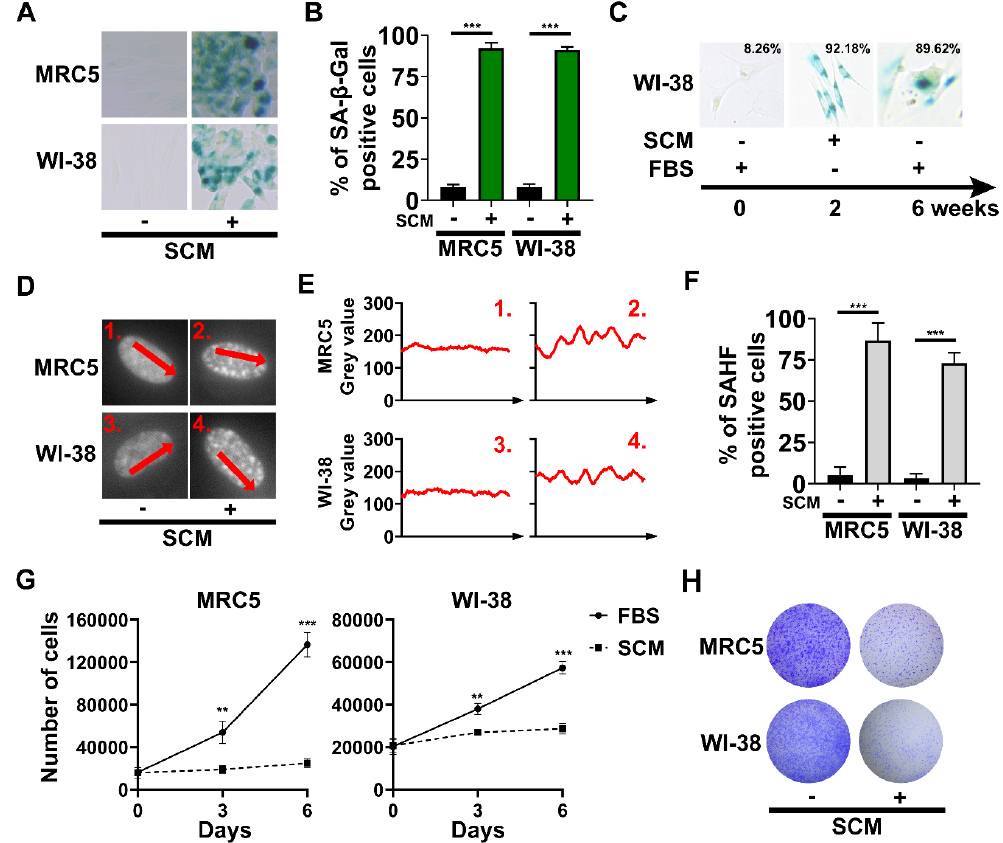
Figure 2. Senescence-associated biomarkers in MRC5 and WI-38 cells treated with stem cell medium (SCM). ( A ) Representative images for senescence-associated beta-galactosidase (SA- β -gal) staining at 48 h. ( B ) Quantification of SA- β -gal shown in A . ( C ) WI-38 cells grown in SCM for two weeks, followed by 10% FBS media for four weeks. Representative images for SA- β -gal staining at each timepoint condition. Numbers in the upper-right corner of each picture represent the percent of SA- β -gal positive cells ( D ) Representative images of stained nuclei at 72 h. ( E ) Linescan analysis (ImageJ software) of fluorescence intensity profiles along the arrows 1–4 indicated in D . ( F ) Quantification of cells with senescence-associated heterochromatin foci (SAHF) . ( G ) Cell proliferation curve of MRC5 and WI-38 cells grown in FBS and SCM. A total of 15,000 cells were plated overnight in a 12-well cell culture plate. Counting began on the following day after the cells became attached to the bottom of the wells. Cell nuclei were stained with Hoechst 33342 and counted based on fluorescence microscopy images taken at each time point. ( H ) Images showing crystal violet staining of cells grown in SCM for three days, followed by 10% FBS media for 20 days. ( B , F , and G ) Student’s t -test; bars represent standard deviation and asterisks indicate statistical significance (**, p ≤ 0.01; ***, p ≤ 0.001; n =